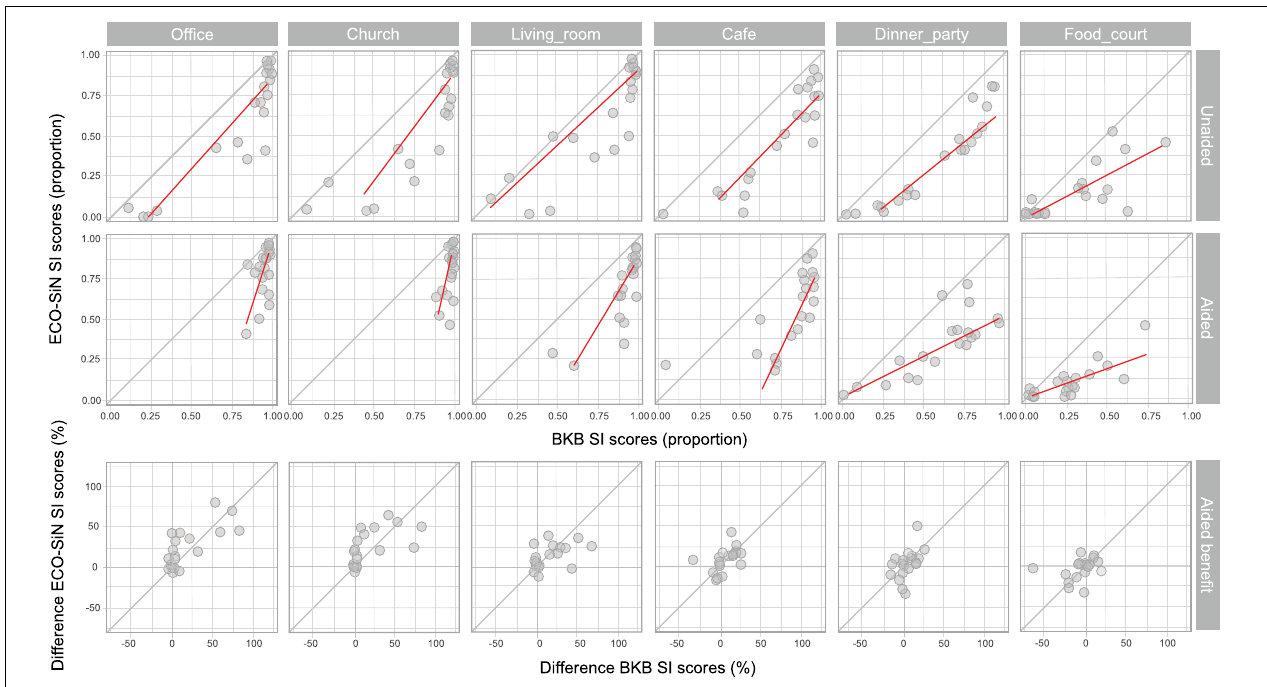
FIGURE 5 | Individual speech intelligibility (SI) scores for ECO-SiN as a function of BKB. Top row: unaided listening; middle row: aided listening; bottom row: hearing-aid benefit (difference between aided and unaided scores).